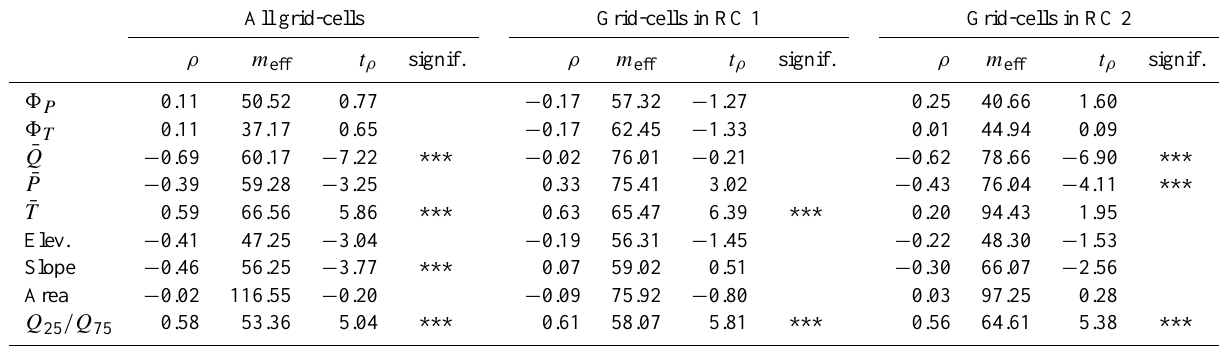
Table 1. Spearman’s rank correlation coefficients ( ρ ) between the fraction of low-frequency variance of runoff ( 8 Q ) and the following set of variables: Fraction of low-frequency variance of precipitation ( 8 P ) and temperature ( 8 T ); mean annual runoff ( ¯ Q ), precipitation ( ¯ P ) and temperature ( ¯ T ); the ratio of 25 and 75 percentile of daily runoff Q 25 /Q 75 ; as well as mean catchment elevation (Elev.), slope and area.